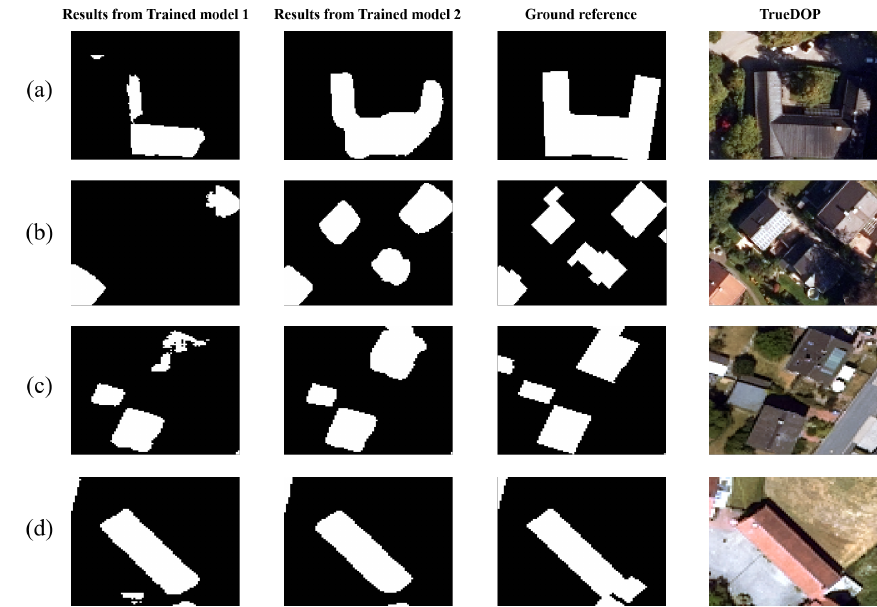
Figure 10. Two examples ( a , b ) represent the buildings detection results in the district of Bad Toelz obtained from trained model 1 and trained model 2, respectively. Two examples ( c , d ) represent the buildings detection results in the district of Nuernburg obtained from trained model 1 and trained model 2,